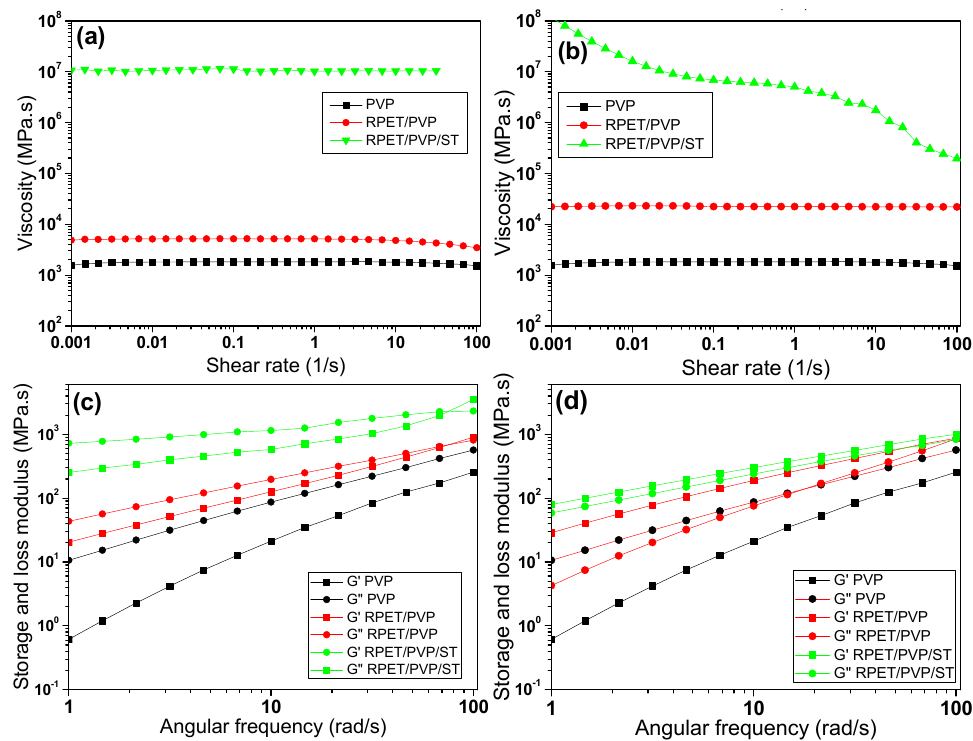
Figure 2. Rheology of the polymer solutions: ( a , b ) viscosity and ( c , d ) frequency sweep test results before and after thermal treatment, respectively.